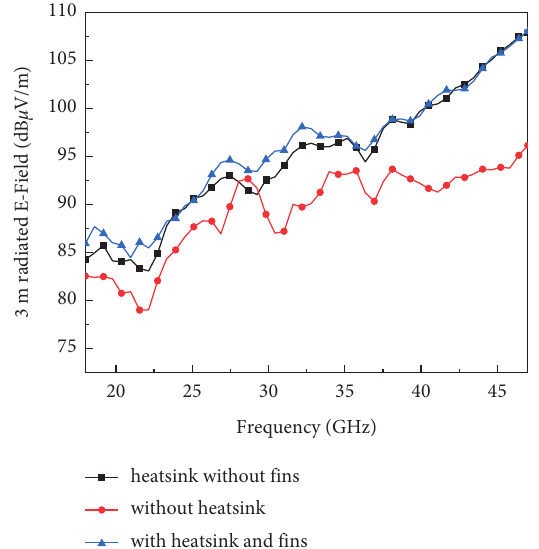
Figure 3: 3m E-field with or without heatsink and fins.